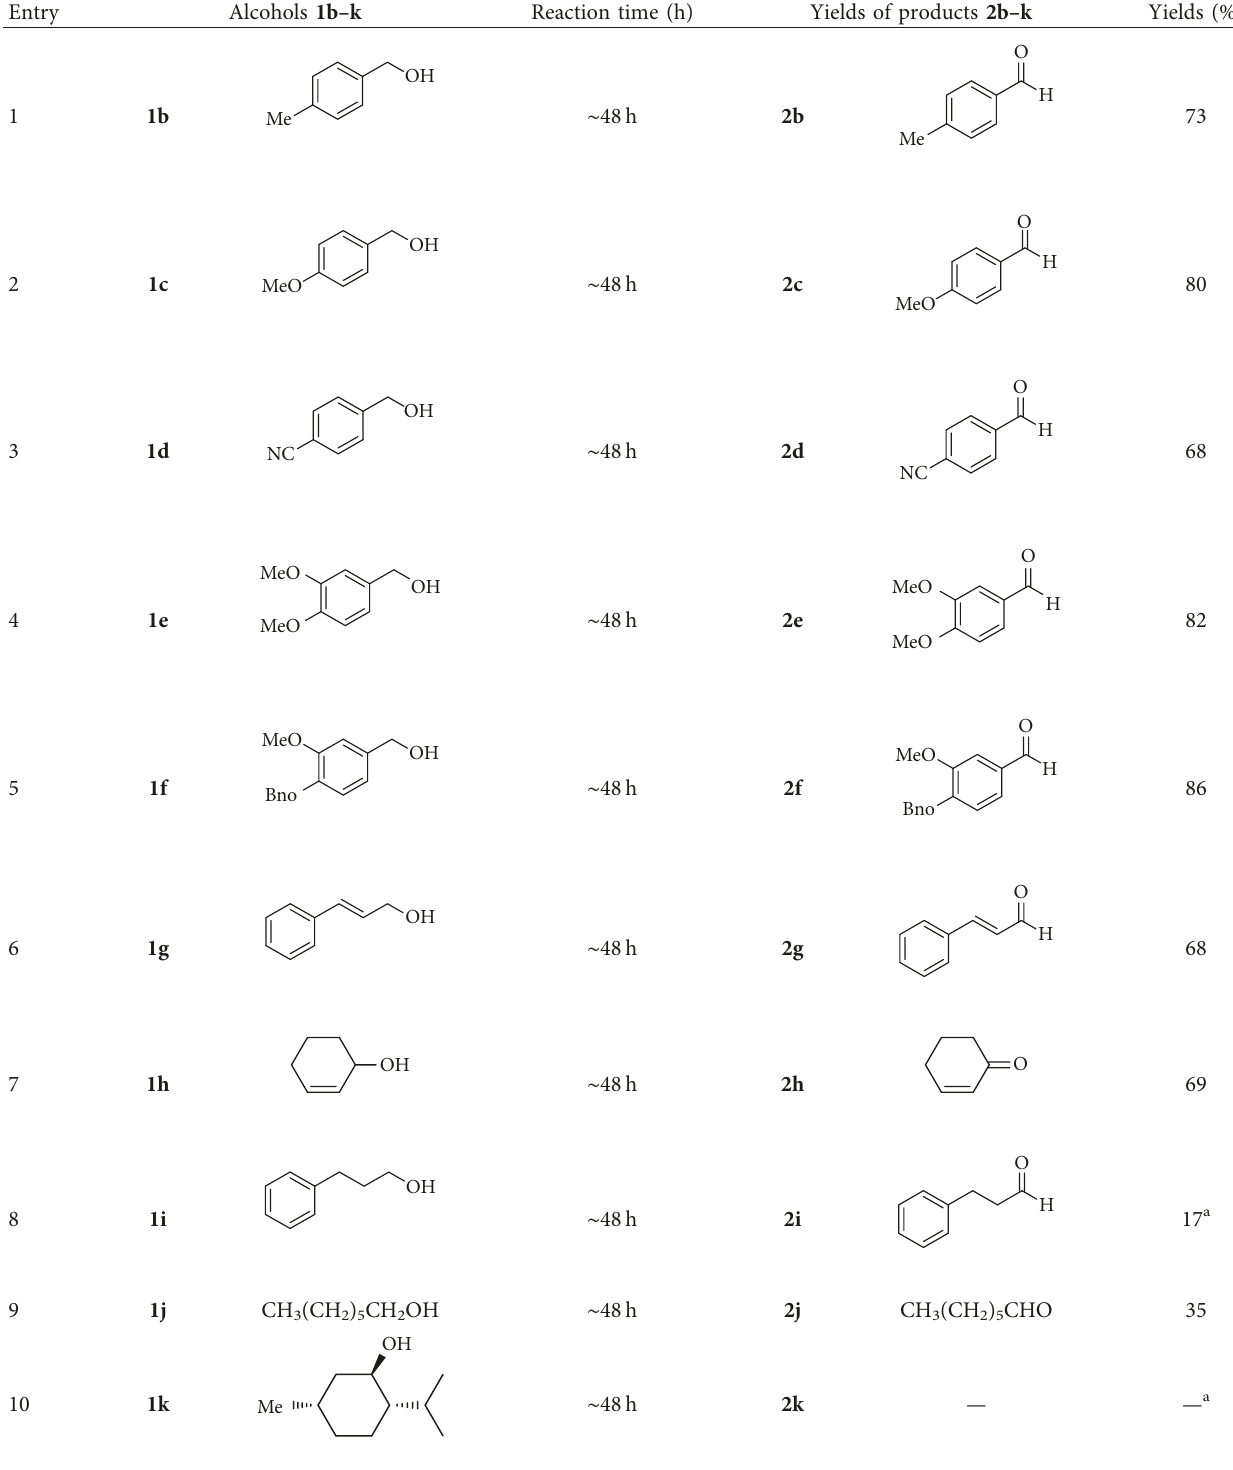
Table 2: Oxidation results of alcohols with RuCpCl(PPh